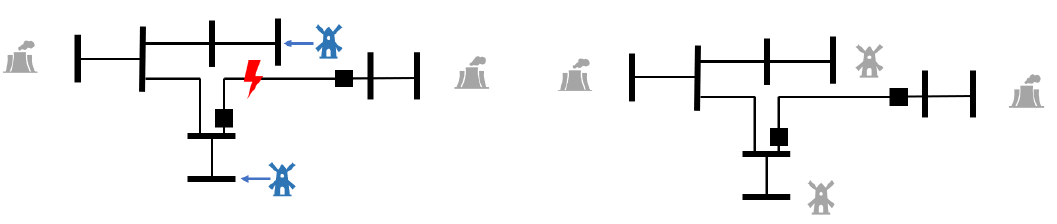
Figure 8. Power system with distributed and utility sources—utility sources